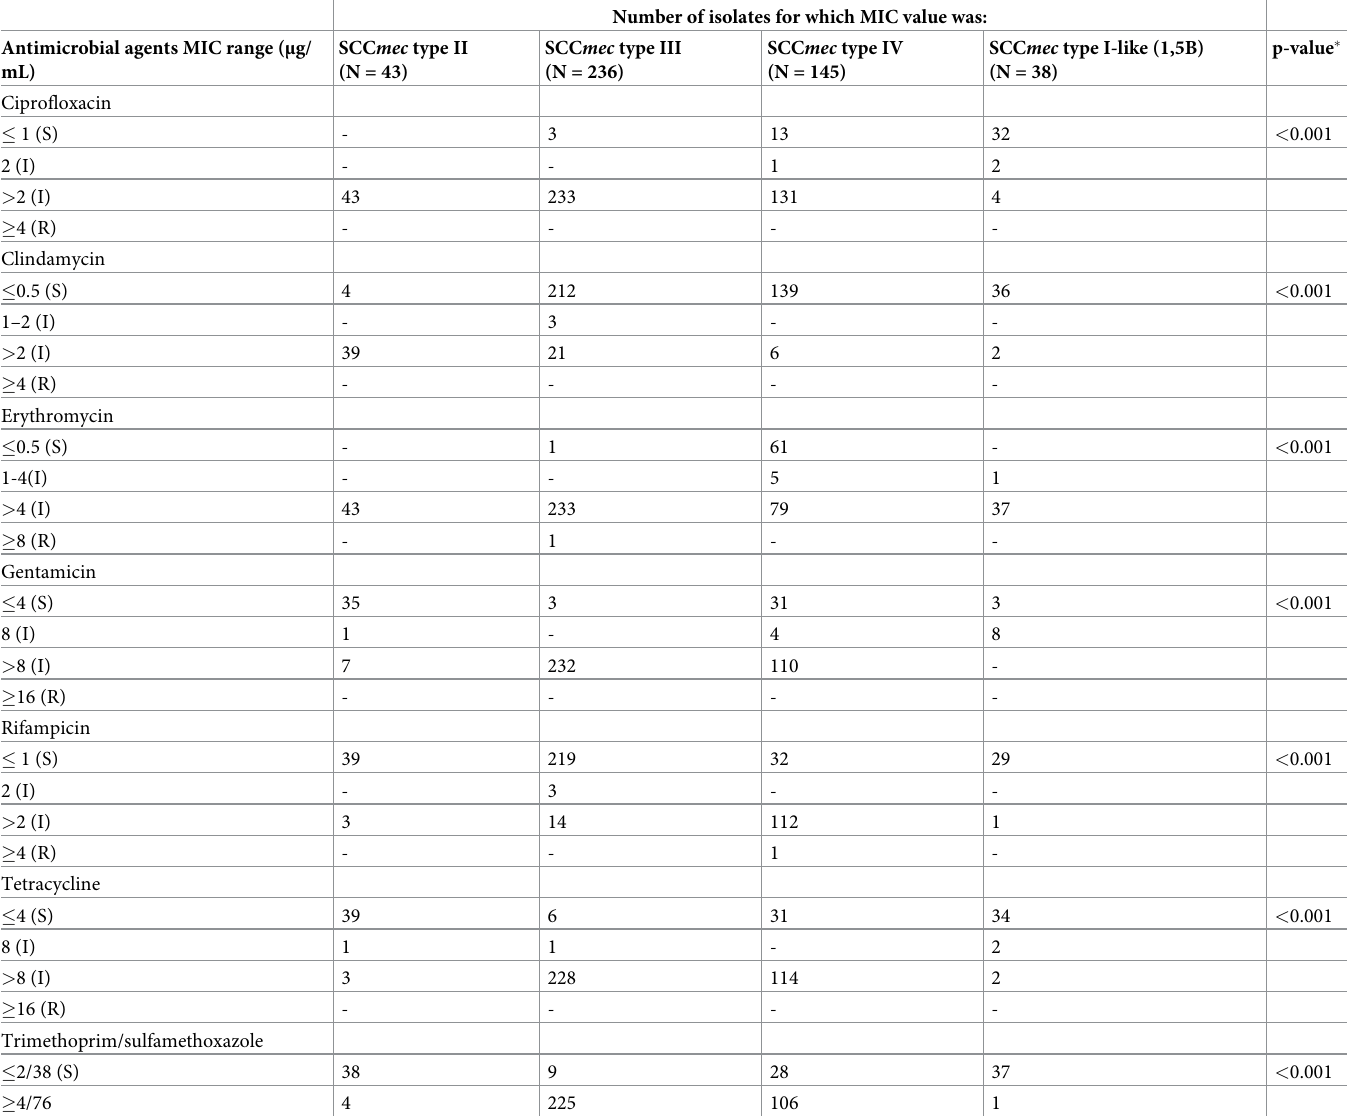
Number of isolates for which MIC value was: